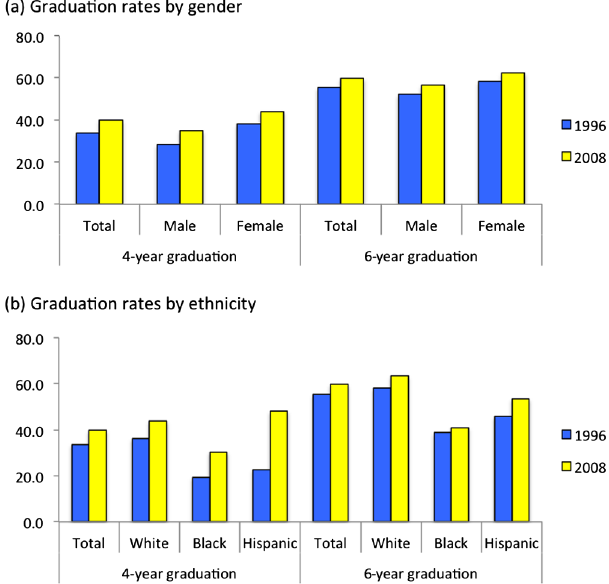
FIG. 1. Graduation rates in 1996 and 2008 (a) by gender and (b) by ethnicity. The 4-year graduation rates increased by about 6%, compared to 4% increase of the 6-year graduation rates, for both males and females. By ethnicity, only the increase in 4-year graduation rate for Hispanics (25.3%) and Blacks (10.9%) was substantial